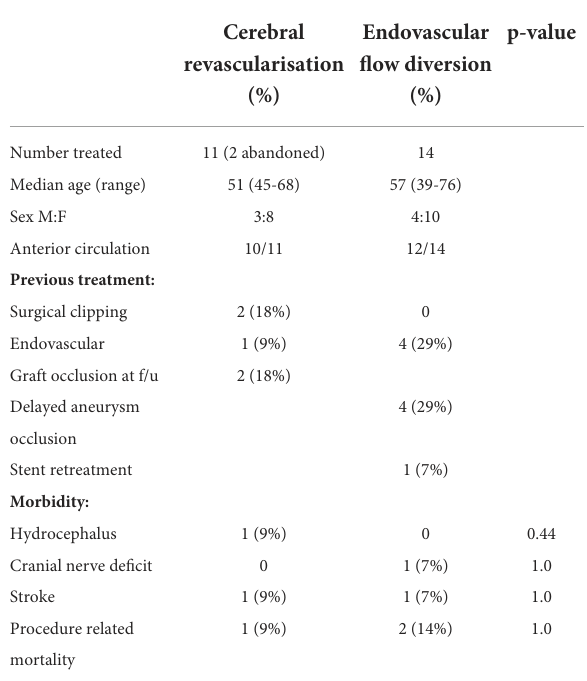
TABLE 2 Treatment of giant/fusiform aneurysm demographics and treatment